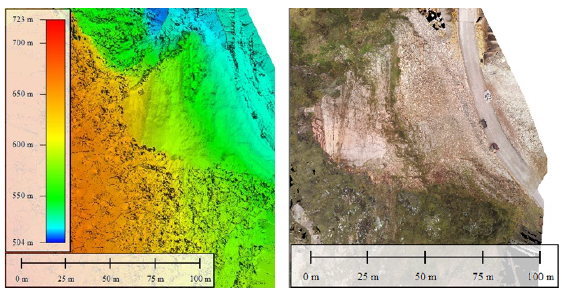
Figure 5. Map view of the DSM (left) and Orthomosaic (right) of the area under investigation at Proussos, Greece.